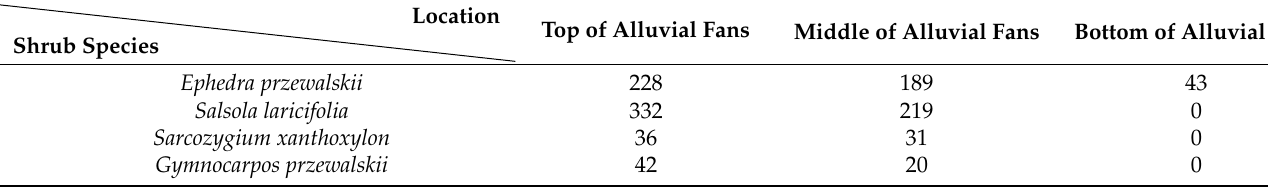
Table 5. The average number of each shrub species at the top, middle, and bottom of alluvial fans in unmanned aerial vehicle (UAV) images of 38 sample plots in the Gobi